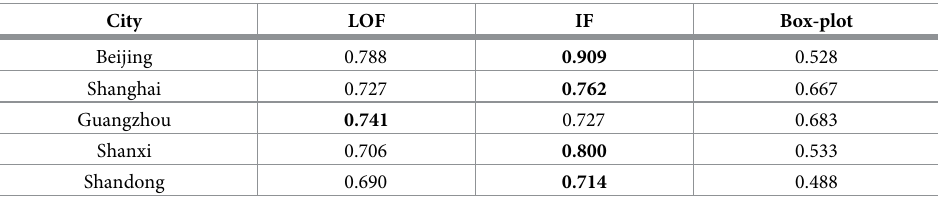
Table 2. Performance of